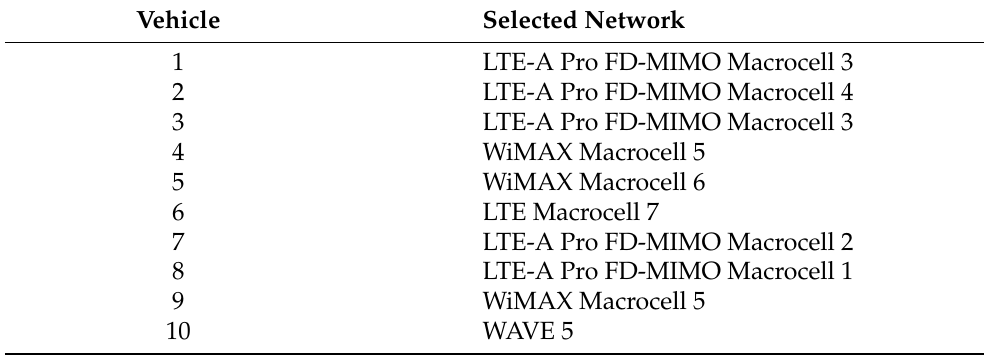
Table 5. The network that each vehicle selects.